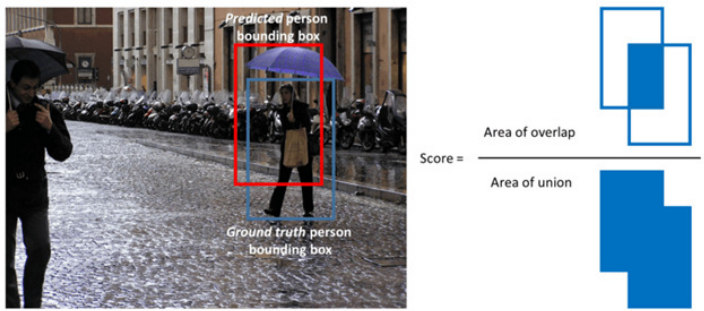
Figure 5. Intersection over union